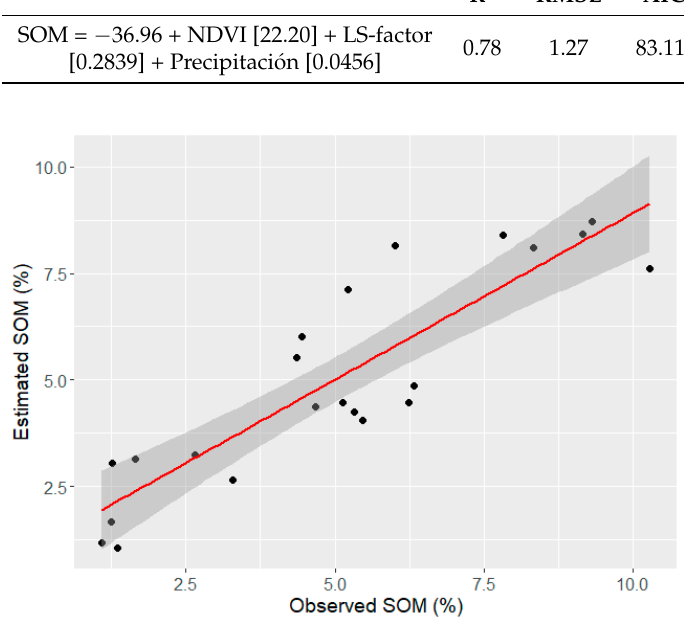
Figure 4. Scatter plot of observed SOM vs. predicted SOM by the MLR